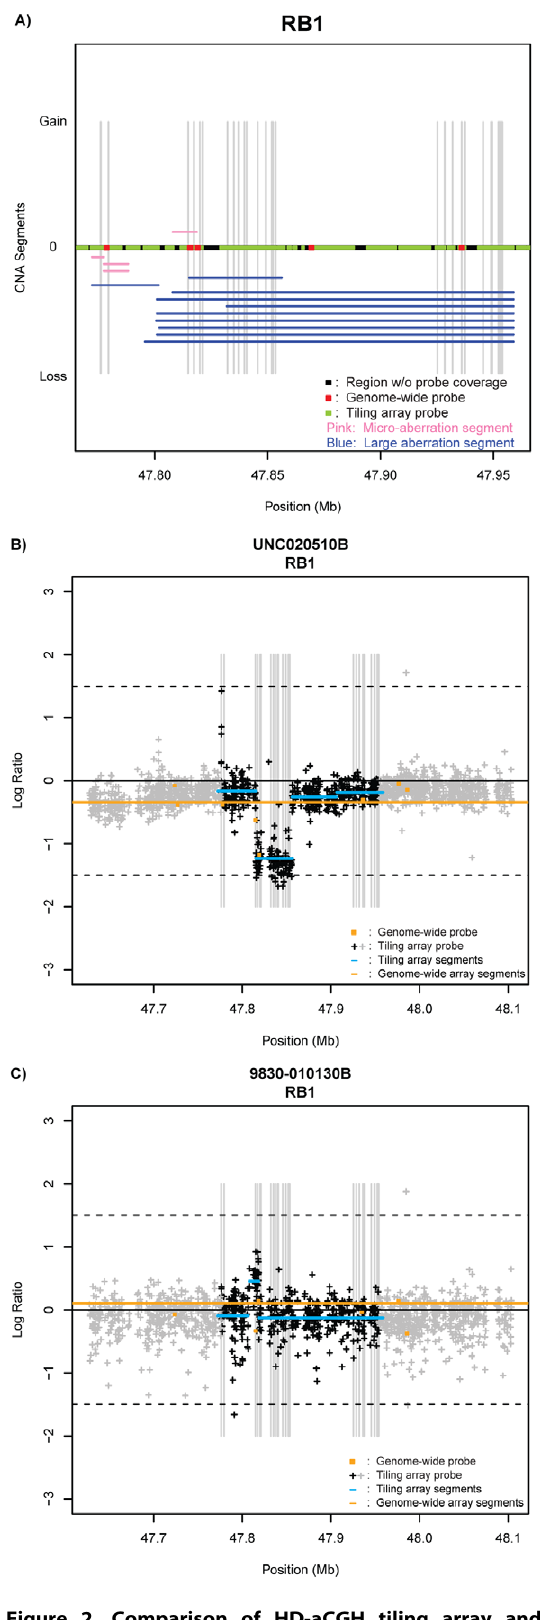
Figure 2. Comparison of HD-aCGH tiling array and 109K Illumina SNP platform generated SWITCHdna copy number segments for RB1. A) Using the 49 samples in common